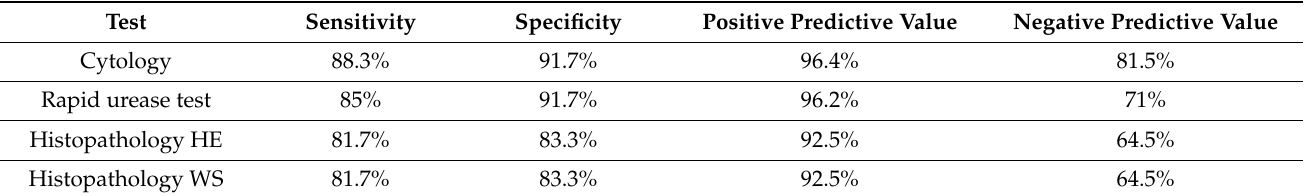
Table 4. Comparison of the diagnostic value of cytology, rapid urease test and histopathology to PCR in the study of 84 dogs with chronic gastrointestinal